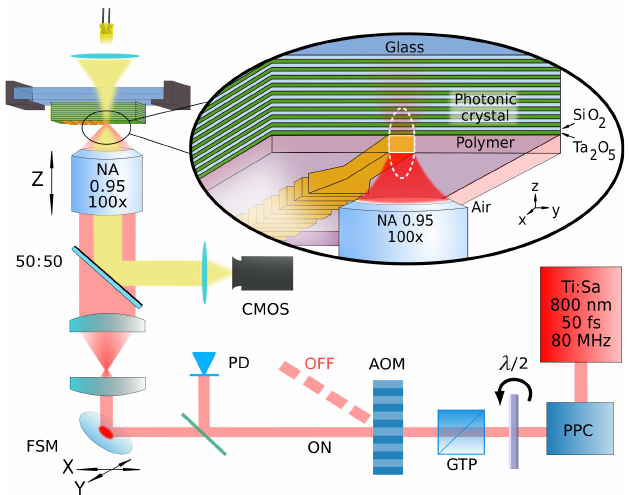
Figure 1. Femtosecond laser polymerisation lithography experimental scheme. The enlarged area represents an experimental sample being structured: a 1D photonic crystal with a polymer layer on the